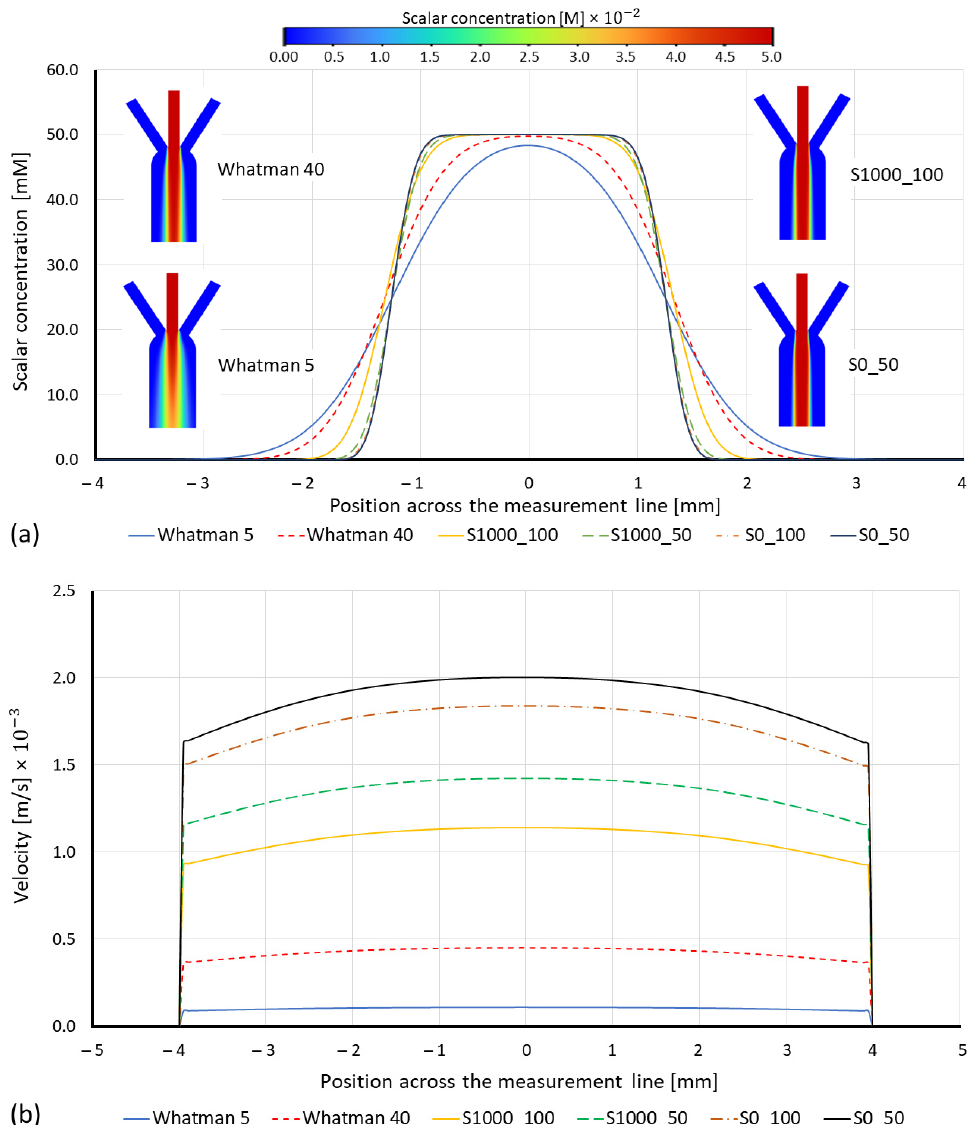
Figure 4. ( a ) Numerical simulation results of the species diffusion width with respect to the papers’ substrate, and ( b ) fluid velocity across the measurement line for different paper substrates.